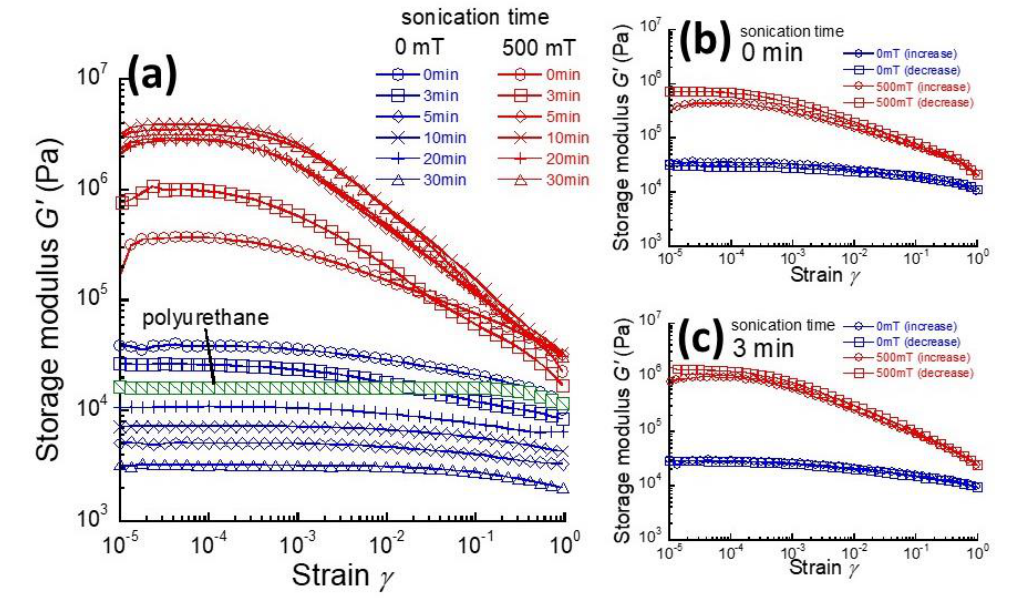
Figure 1. ( a ) Strain dependence of storage modulus for magnetic elastomers with various sonication times at 0 and 500 mT. Hysteresis in storage modulus for magnetic elastomers with sonication: irradiation time ( b ) 0 min and ( c ) 3 min.